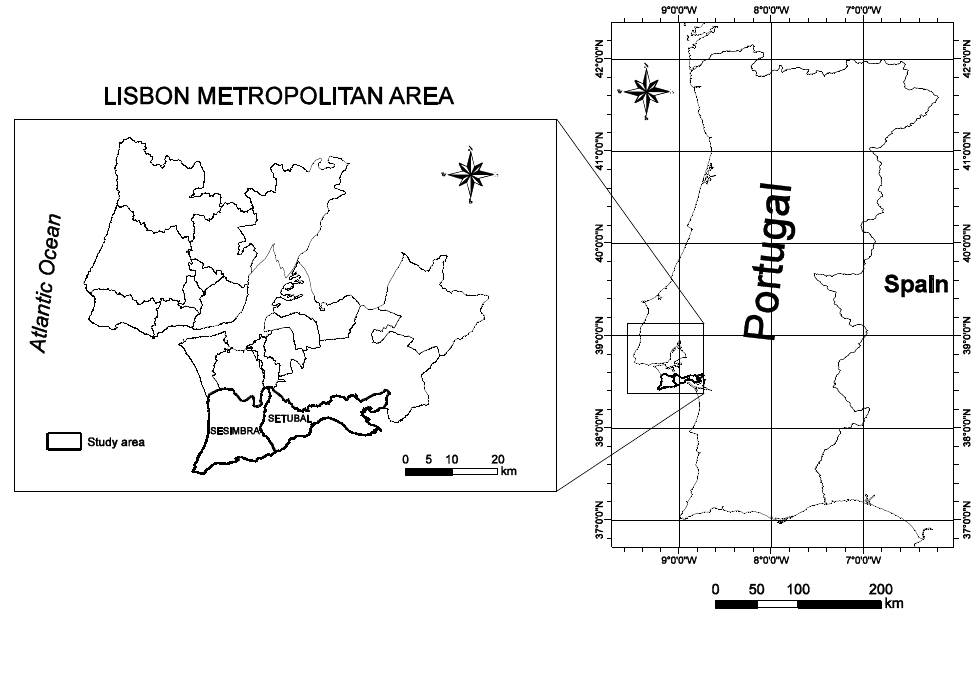
Figure 1. Location of the study area: two administrative areas, Setúbal and Sesimbra, in the Lisbon Metropolitan Area (AML),